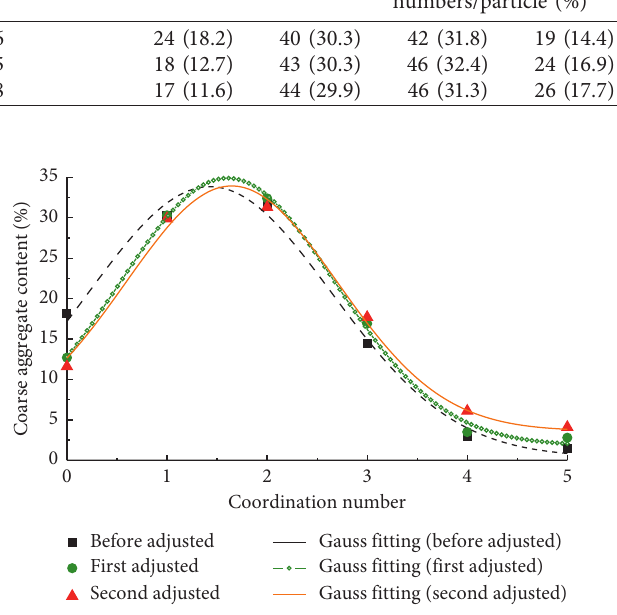
Figure 9: Coordination number Table 8: Marshall test results.